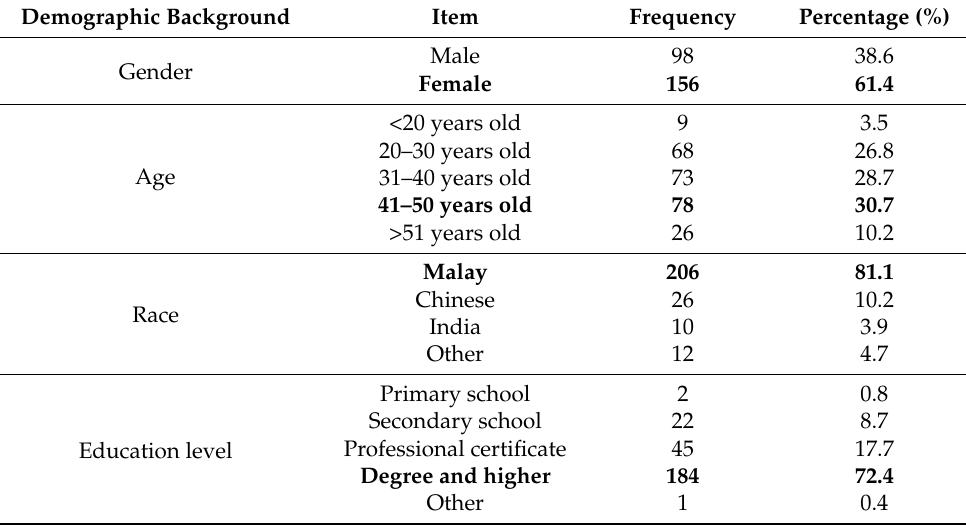
Table 2. Sociodemographic data of